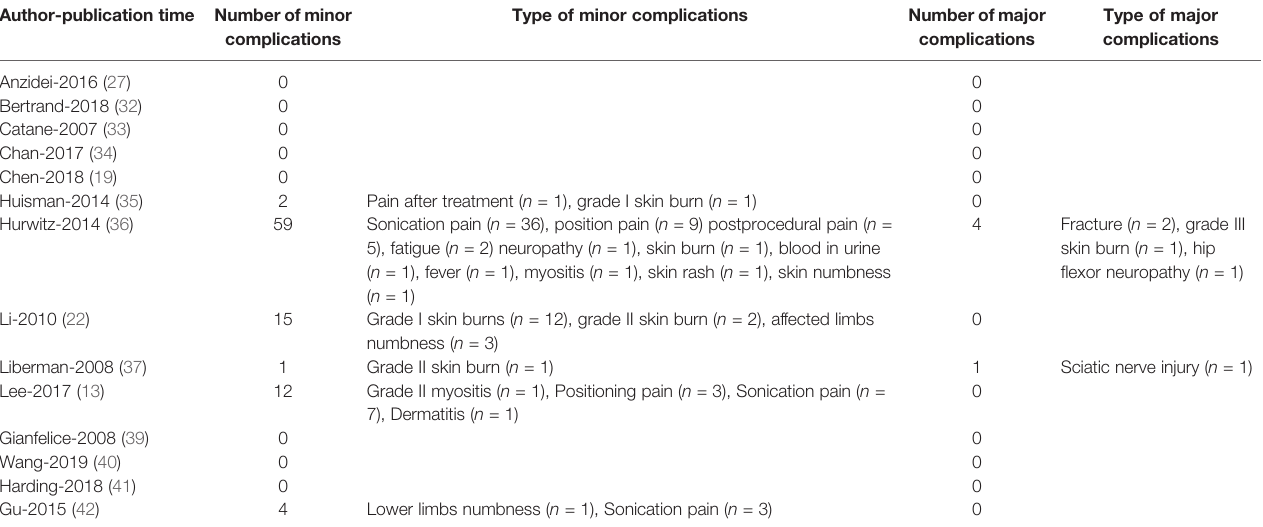
TABLE 3 | Complications of